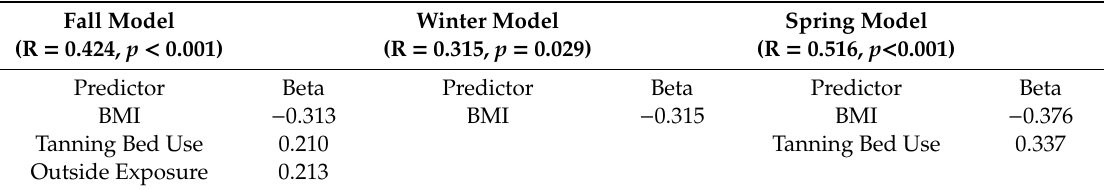
Table 3. Predictors of Serum 25(OH)D Concentration (Study